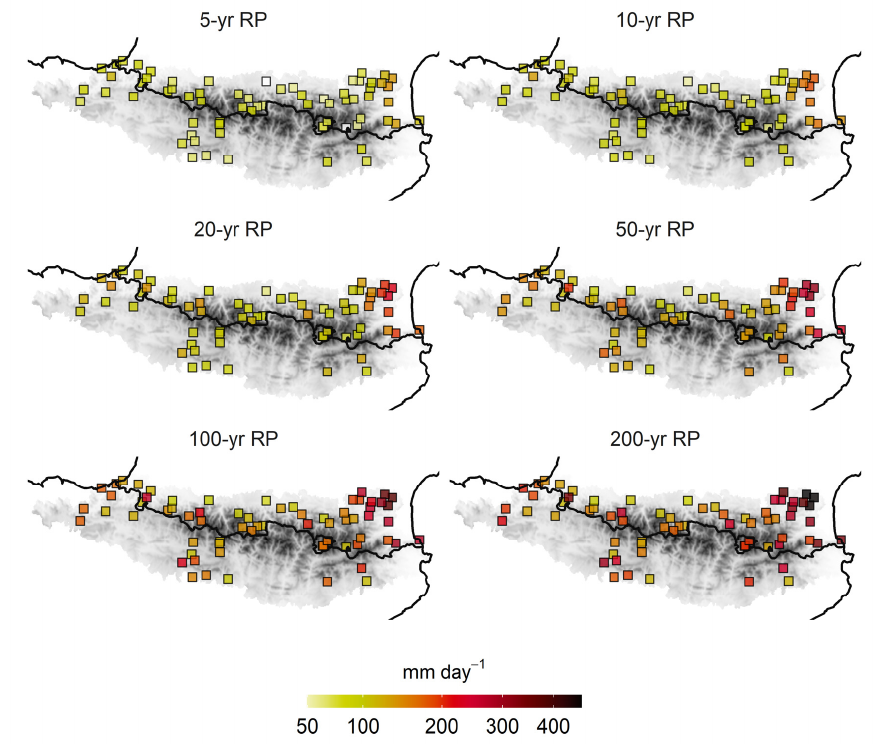
Figure 2. Return levels of maximum daily precipitation per year for 6 different return periods (RPs): 5, 10, 20, 50, 100 and 200 years. Only the stations with the complete series were used.